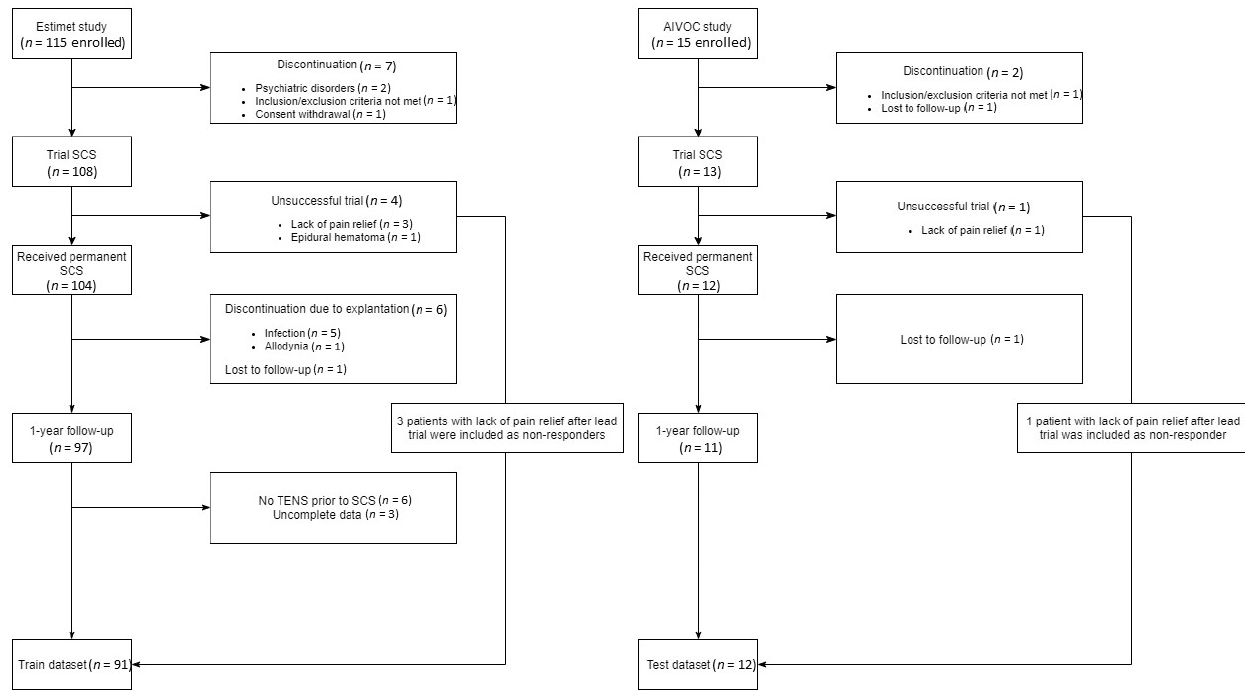
Figure 1. Flowchart of the patients who participated in ESTIMET and AIVOC included in this study.